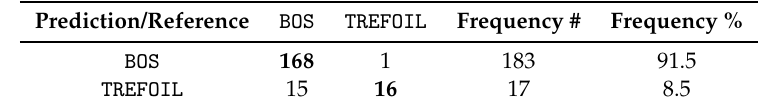
Table 9. Results on small logo detection on an unseen validation dataset, performed by Adidas team. The numbers of correct predictions per class (on the main diagonal of the matrix) are highlighted in boldface font.